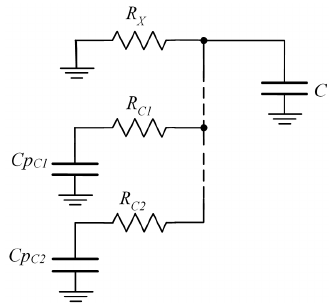
Figure 3. Two-point calibration circuit showing RC crosstalk due to stray capacitors.